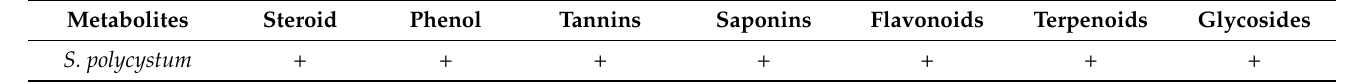
Table 5. Phytochemicals from S. polycystum .